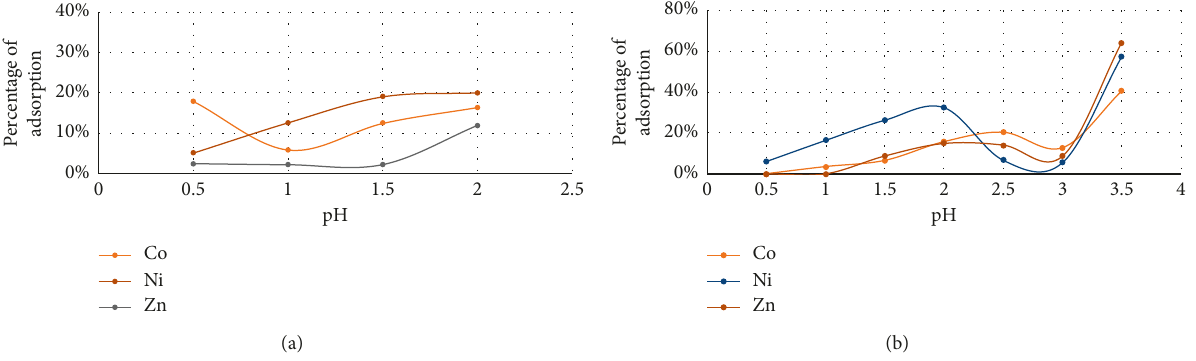
Figure 5: Effect of pH in Solution 2 by the bis-picolylamine resin (a) without and (b) with the pre-reducing process.